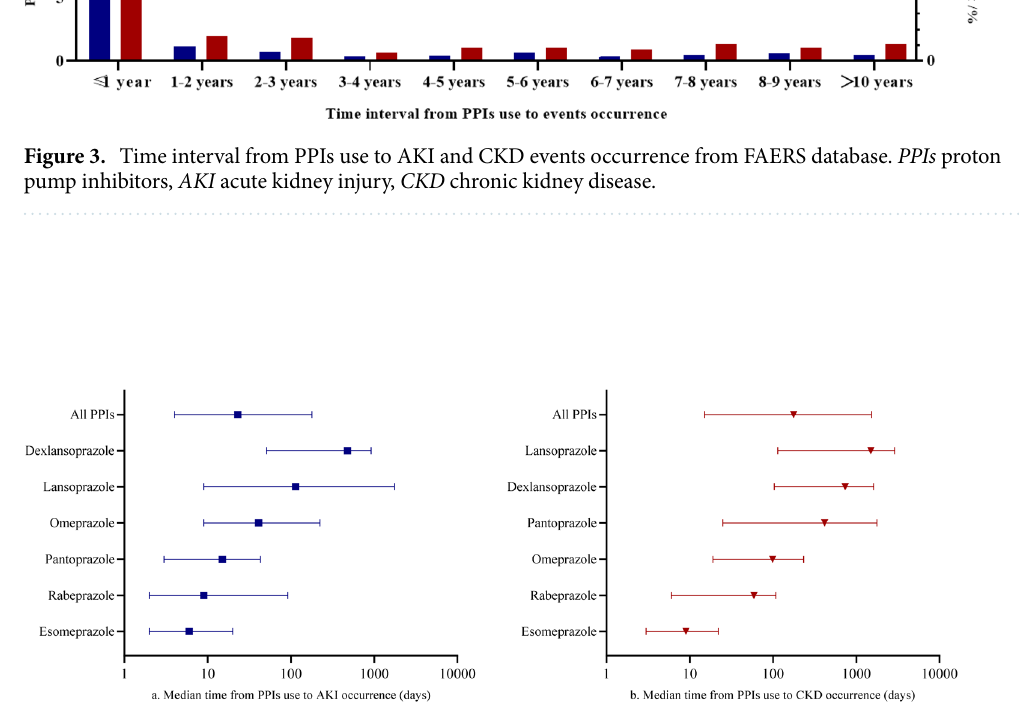
Figure 4. Median time from PPIs use to events occurrence from FAERS database. PPIs proton pump inhibitors, AKI acute kidney injury, CKD chronic kidney